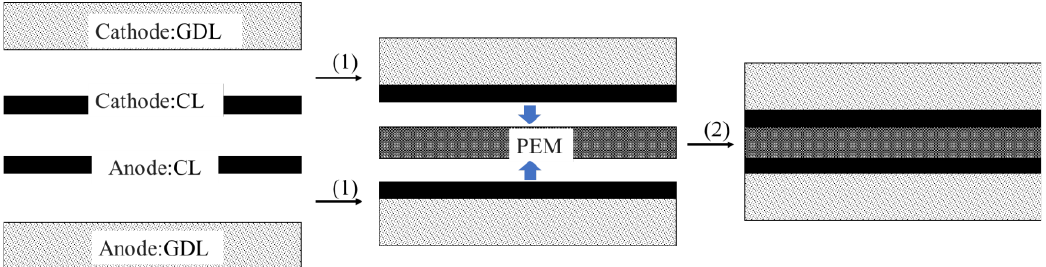
Figure 5. Schematic diagram of the GDE preparation process.